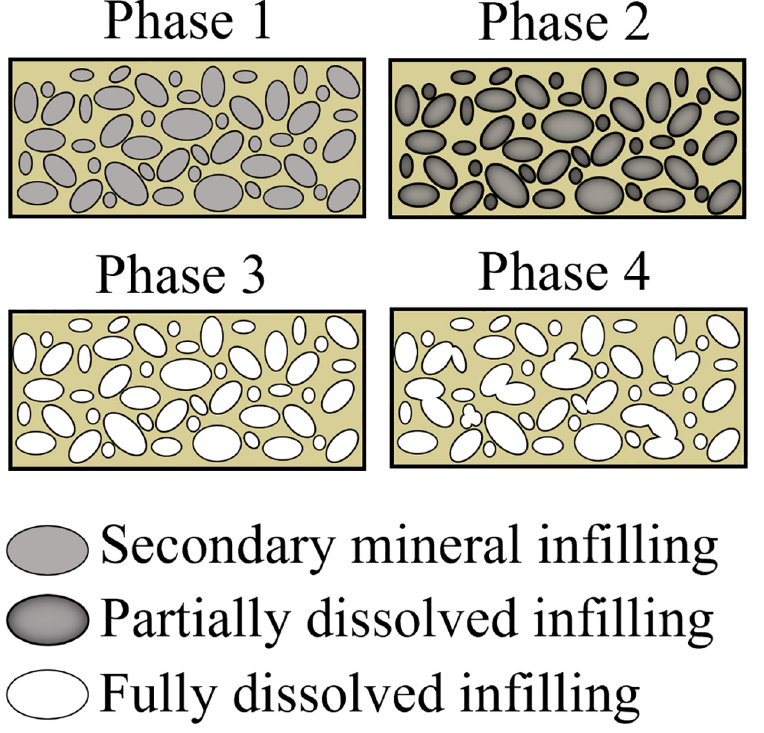
Fig 5. Interpreted effects of dissolution on fossil bone surface area. Cross-sectional schematic diagram demonstrating surface area increases as secondary mineral infilling is dissolved. Phase 1 depicts a fossil with the pore spaces infilled completely by secondary mineral growth. This phase represents the pre-dissolution samples. Phase 2 represents partial dissolution of secondary minerals. Dissolution has not penetrated through the fossil, but dissolution of mineral infilling has created voids that increase pore space, effectively increasing surface area of exposed bone. Phase 3 represents complete dissolution of secondary minerals, and the maximum surface area of the fossil has been attained. Phase 4 is when surface area starts to decrease as pore spaces